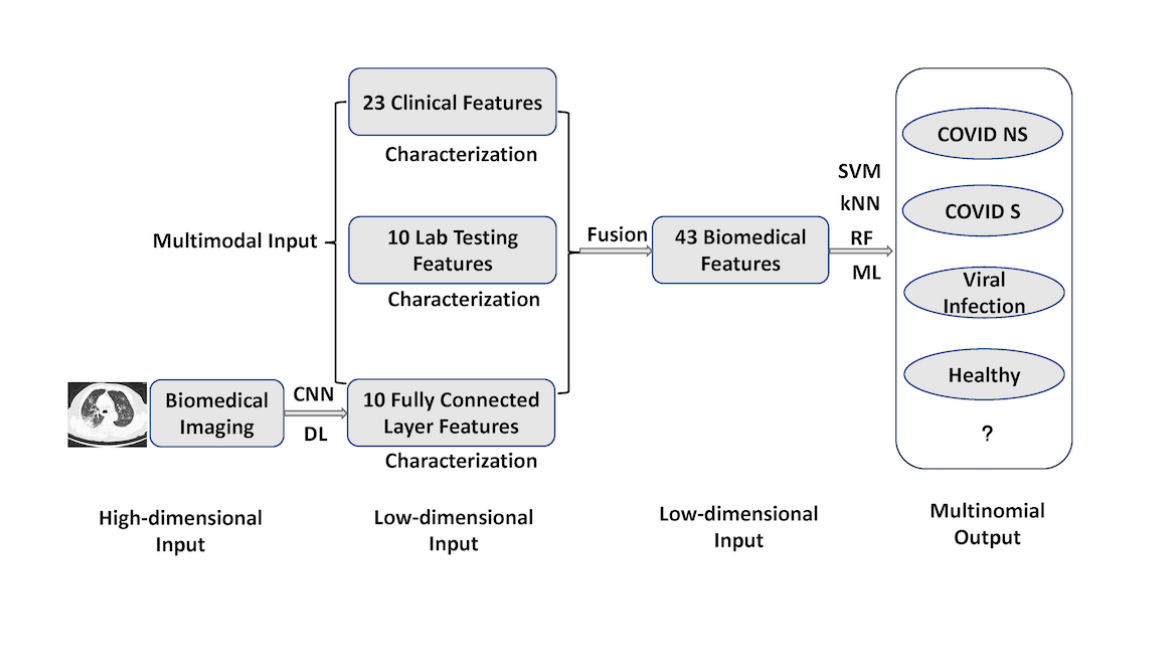
Figure 1. Multimodal feature late fusion and multinomial classification workflow. A deep learning convolutional neural network was applied to computed tomography images for representation learning and extracting 10 features from a customized fully connected layer. These 10 features were merged with other modality data through feature late fusion. In the machine learning stage of the workflow, each of the 3 machine learning models (ie, the support vector machine, k-nearest neighbor, and random forest models) worked independently to provide their respective outputs. kNN: k-nearest neighbor; ML: machine learning; RF: random forest; SVM; support vector